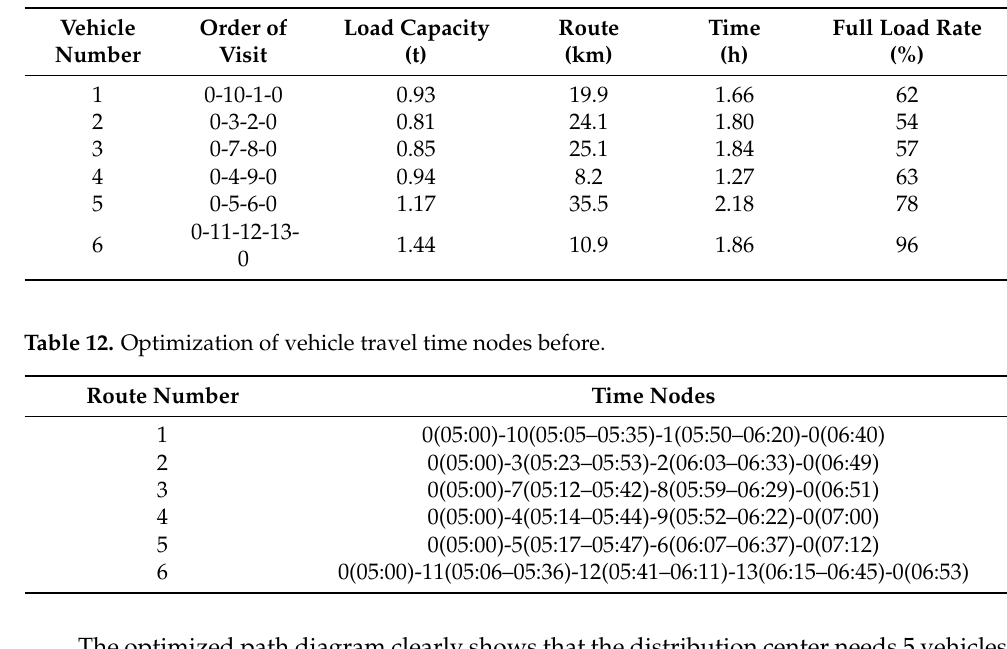
Table 11. List of distribution vehicles before optimization.